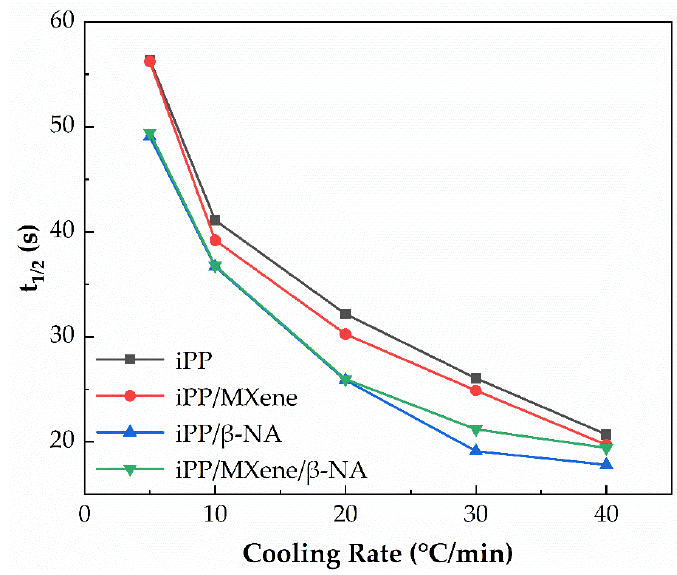
Figure 7. Half crystallization time t 1/2 of four samples at different cooling rates.